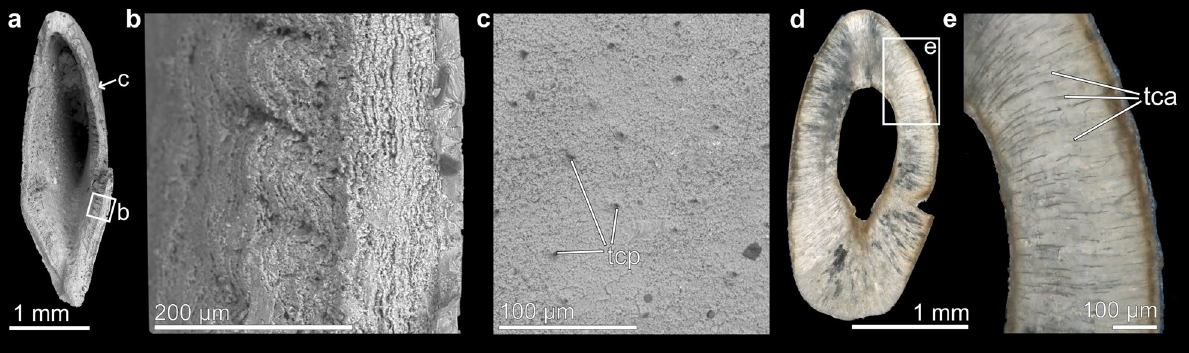
Figure 7. Microstructure of the fossil samples. ( a ) Posterior view of a fossil dactylus fingertip (KGP-MH DU- 002) analysed using SEM. ( b ) Detail of the same specimen, showing three-fold cuticular layering. ( c ) Detail of the surface of the same specimen, showing the external pores of tegumental canals. ( d ) Thin section of a fossil dactylus fingertip (NHMW 2016/0154/0008) as seen under polarised light. ( e ) Detail of the same specimen, showing tegumental canals located inside the cuticle. tca = tegumental canal, tcp = tegumental canal pore.